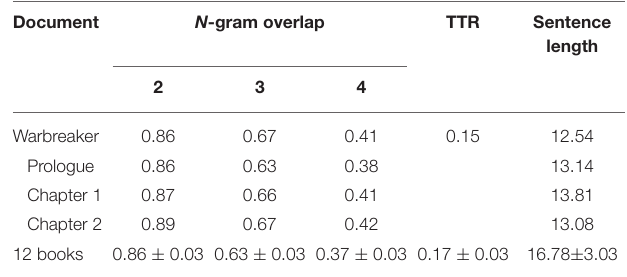
TABLE 1 | N -gram overlap ( n = { 2,3,4 } ), TTR and sentence length for Warbreaker and the means and 95% confidence intervals of those measures for the 12 books previously translated by Toral and Way (in